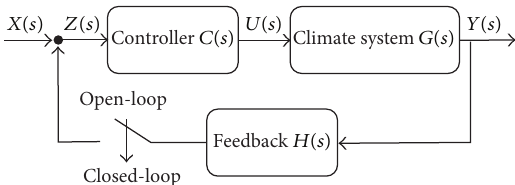
Figure 7: Blog diagram for feedback climate and weather